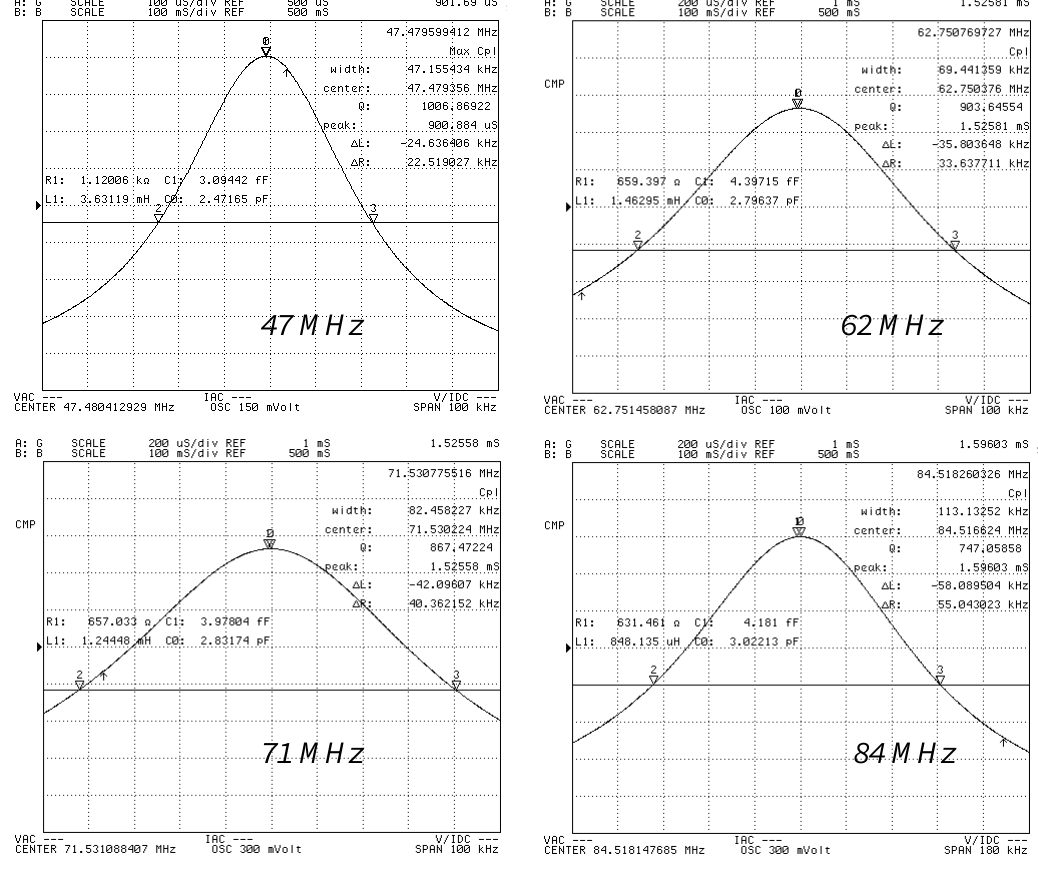
Figure 8. Measured conductance characteristics of 47 MHz, 62 MHz, 71 MHz, and 84 MHz QCM chips in